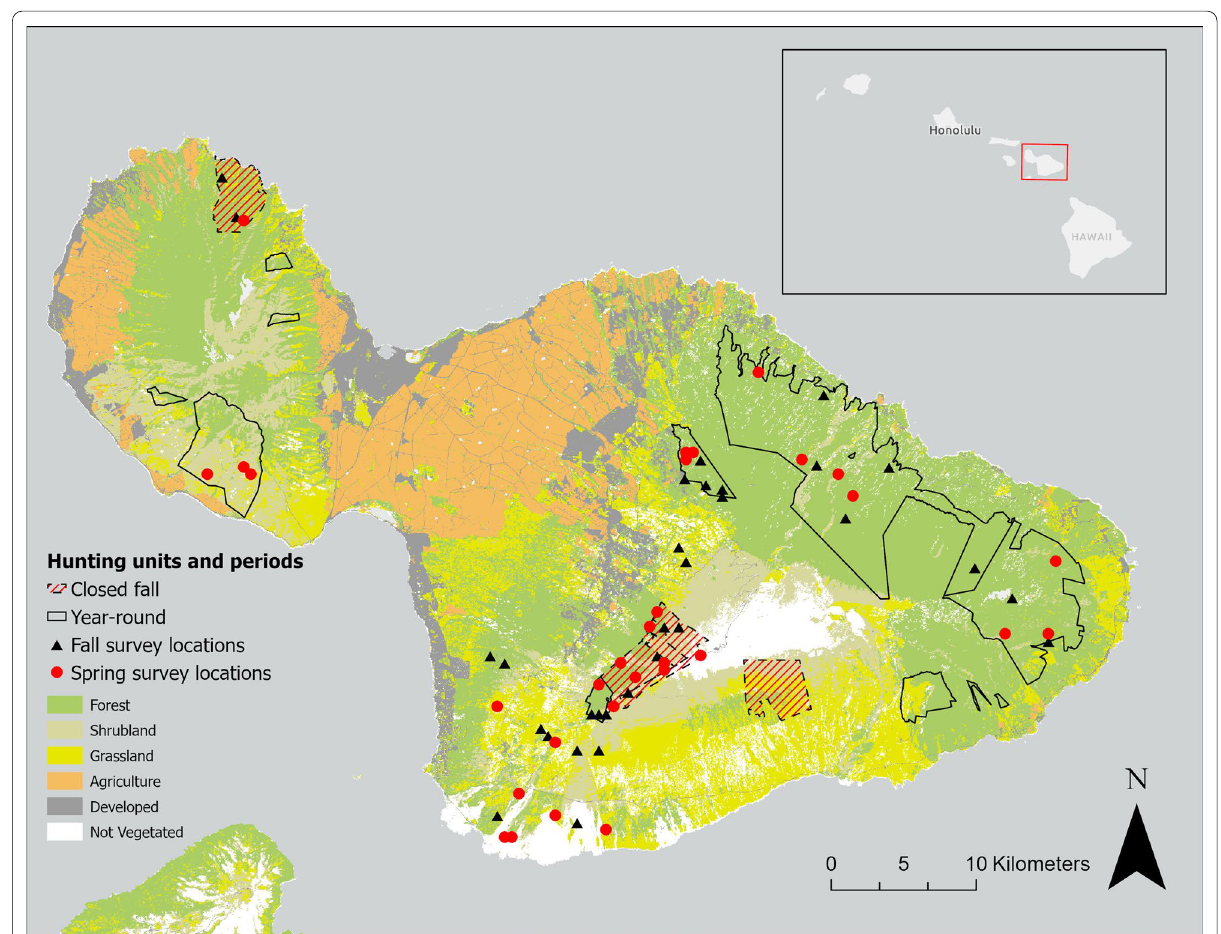
Fig. 1 Location of the study area on the island of Maui, Hawai ʻ i. Location of spring survey locations are shown by circles ( n survey locations are shown by triangles ( n 31). Red-hatched hunting units are closed for pig hunting from February through =